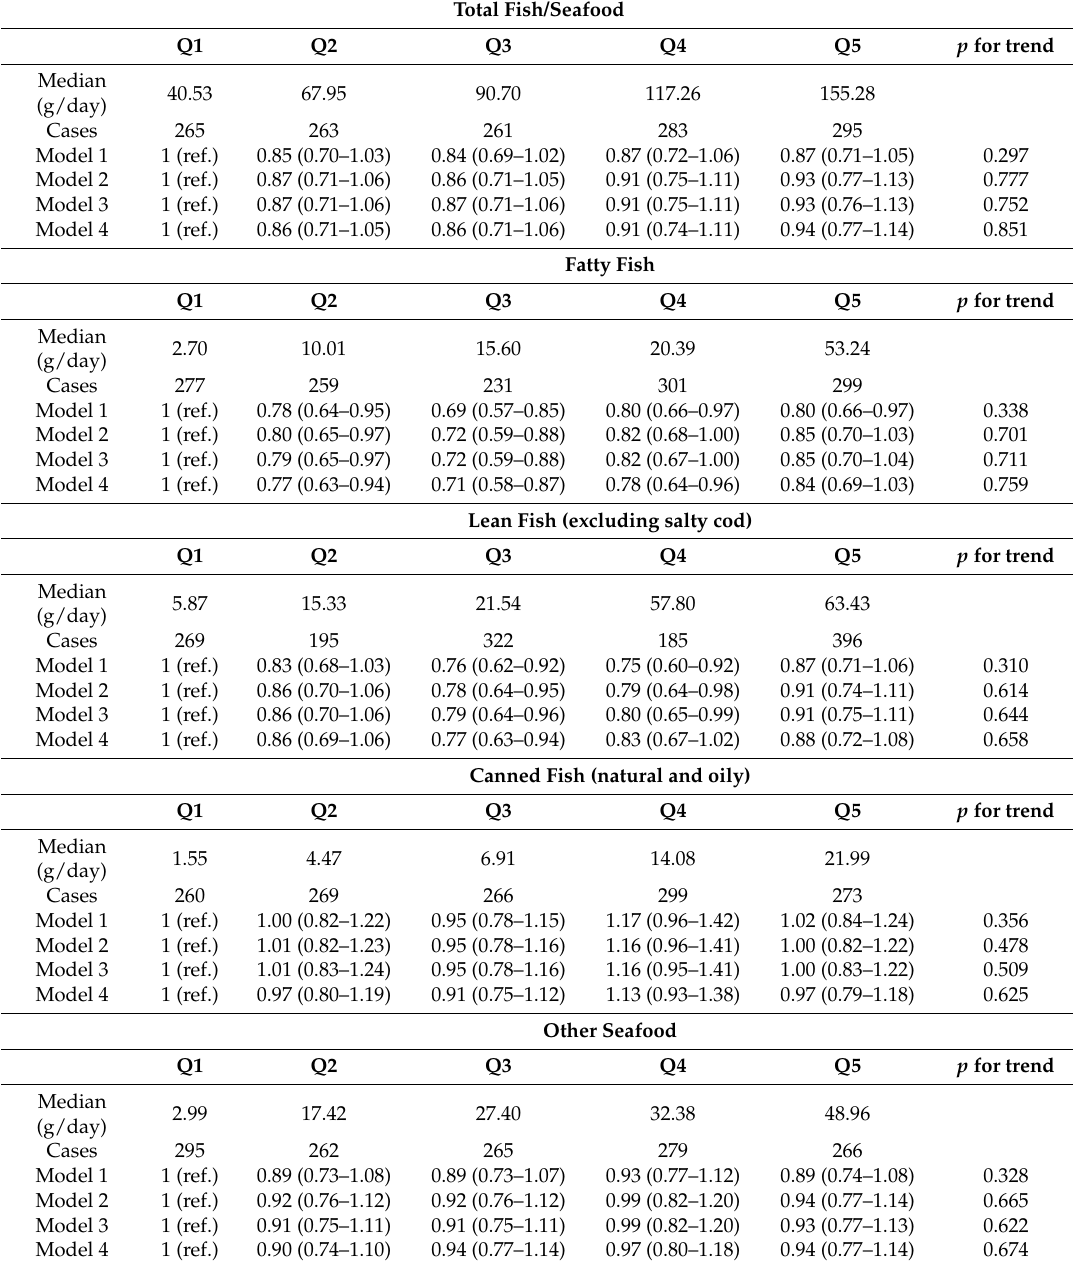
Table 2. Odds ratio (OR) and 95% confidence interval (CI) for the association between energy-adjusted fish/seafood consumption (quintiles) and life-time prevalence of depression in the PREDIMED-PLUS